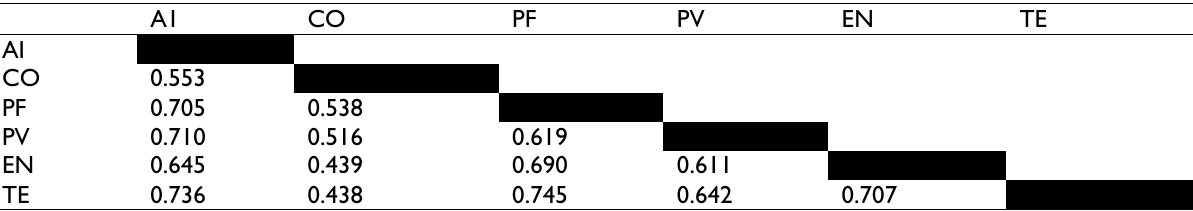
Table 4. Discriminant Validity Test